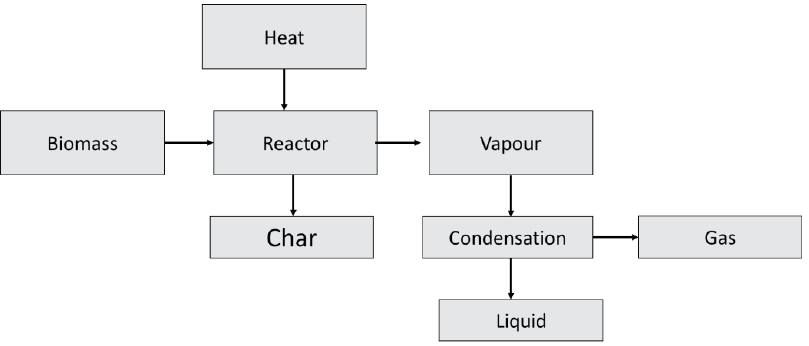
Figure 2. Reaction pathway of pyrolysis process.